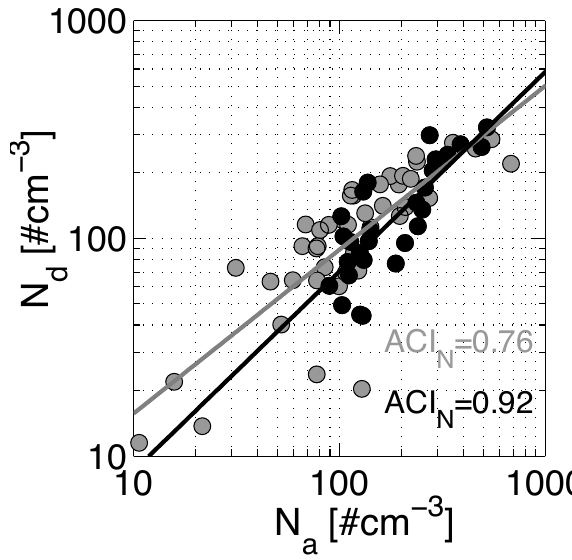
Fig. 13. Scatterplot between N a and in situ N d . Gray circles corre- and in situ N spond to samples collected during all the research flights performed a by the C-130 aircraft. Black circles represent those samples col- lected during the four research flights investigated